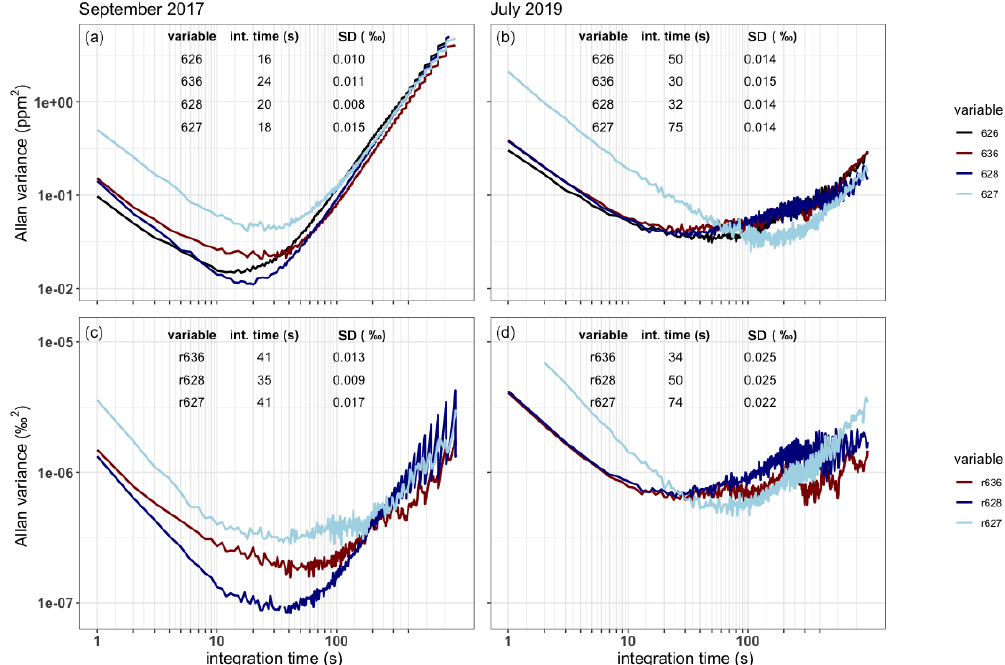
Figure 4. The Allan variance as a function of the integration time in seconds for a single gas measurement plotted for both the measured isotopologue abundance (a, b) and the isotope ratios (c, d) in September 2017 (a, c) and July 2019 (b, d) . The best achieved precision and corresponding integration times are shown as a table in the